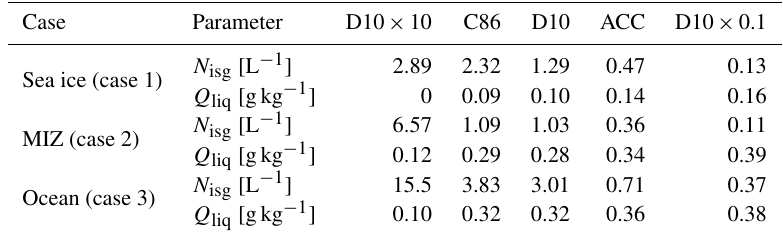
Table 3. Maximum modelled values during each case for each parameterisation implemented at water saturation. Case Parameter D10 × 10 C86